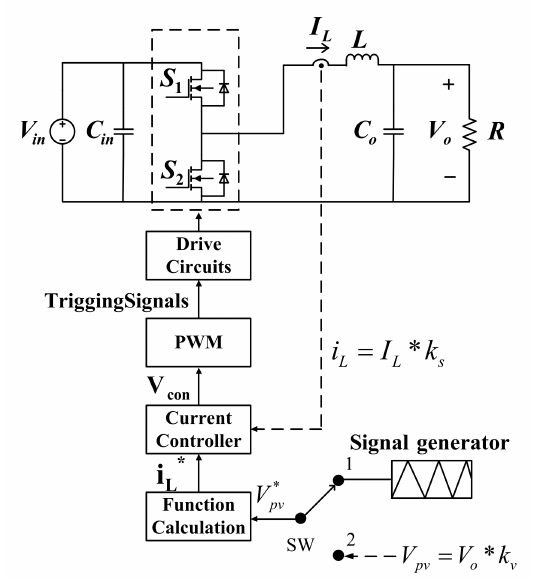
Figure 8. Block diagram of current mode control of synchronous buck